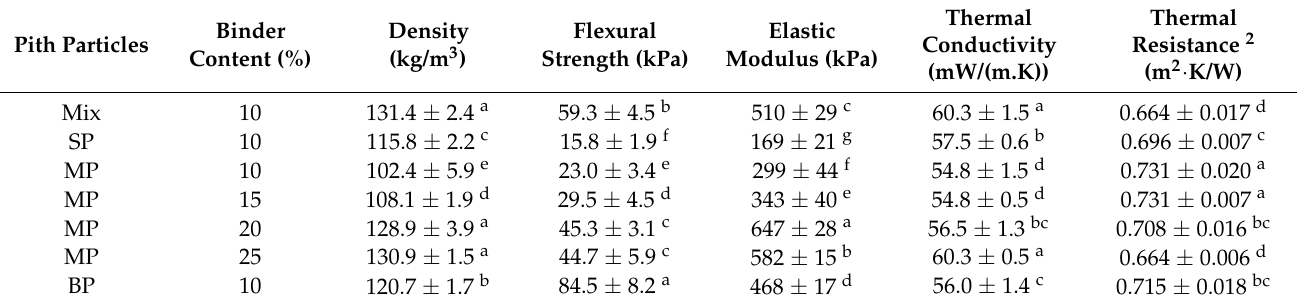
Table 6. Characteristics of the low-density insulation blocks produced from pith particles through compression molding (9 kPa, 5 min, 25 ◦ C) 1